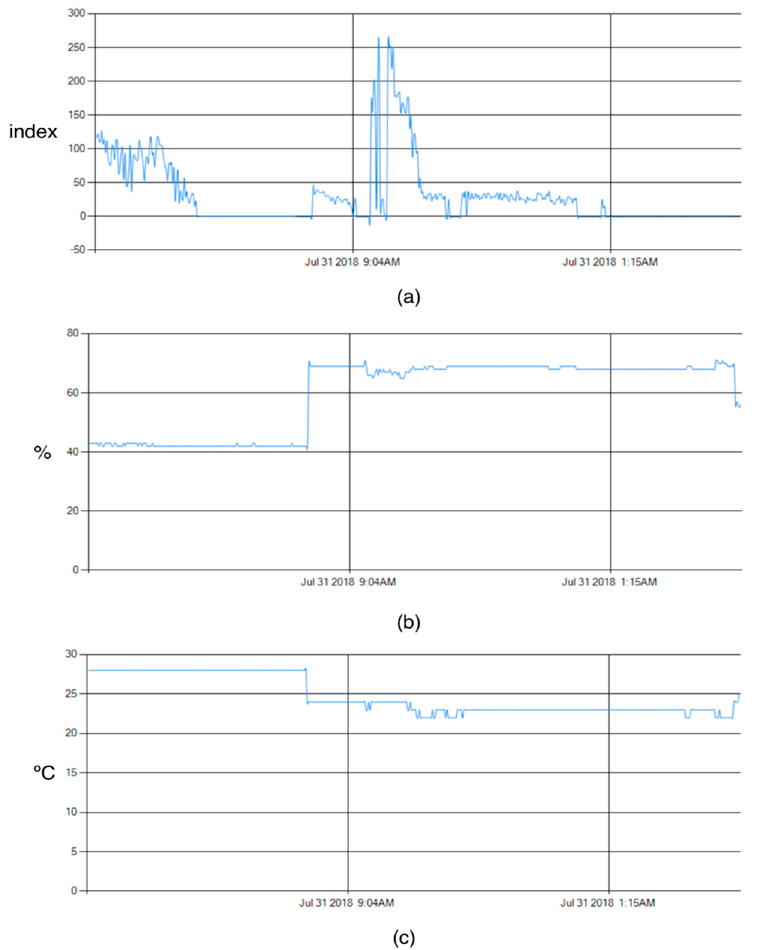
Figure 7. Results of IAQ index, air temperature and relative humidity obtained in the experiments conductedinareallaboratoryenvironment: ( a )IAQindex; ( b )relativehumidity(%); ( c )airtemperature( ◦